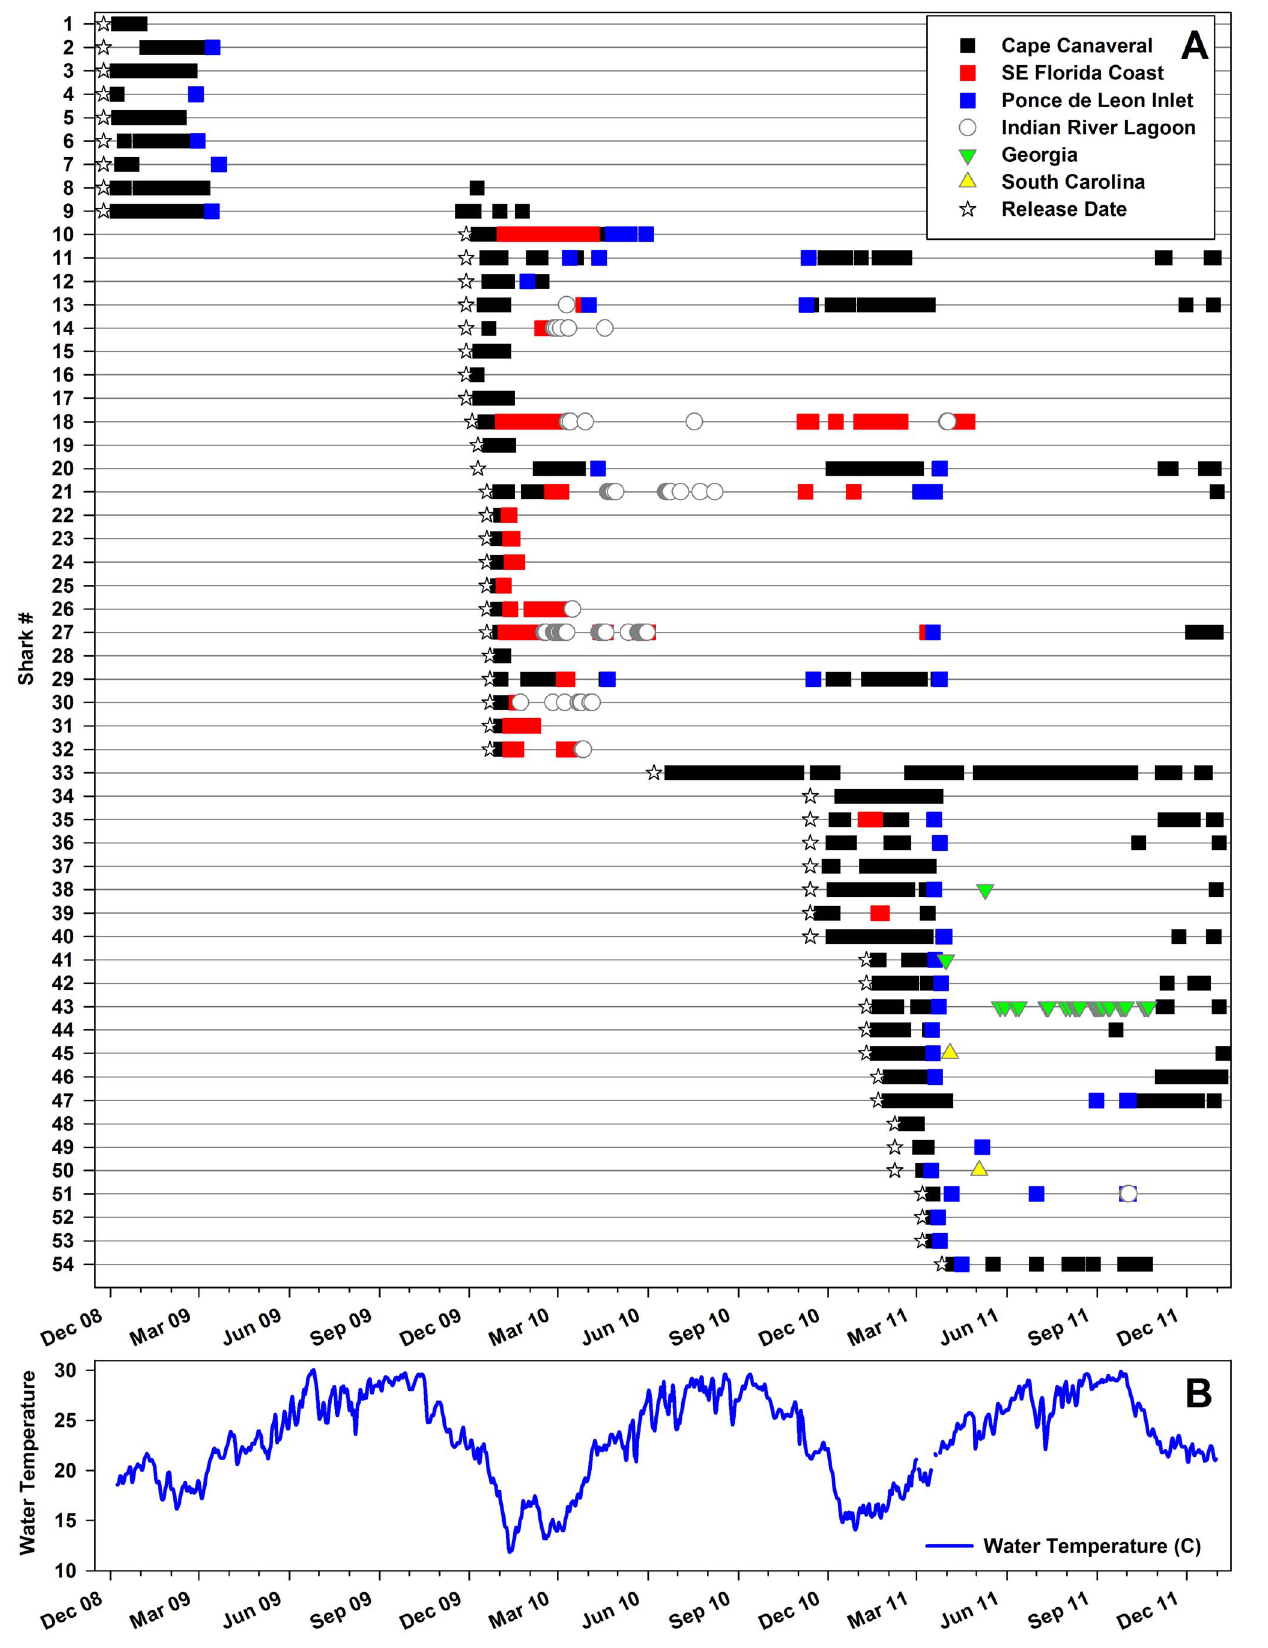
Figure 2. Lemon shark migrations. A) Acoustic detections of all 54 lemon sharks through time, and B) associated nearshore water temperature at Cape Canaveral. doi:10.1371/journal.pone.0088470.g002 PLOS ONE |